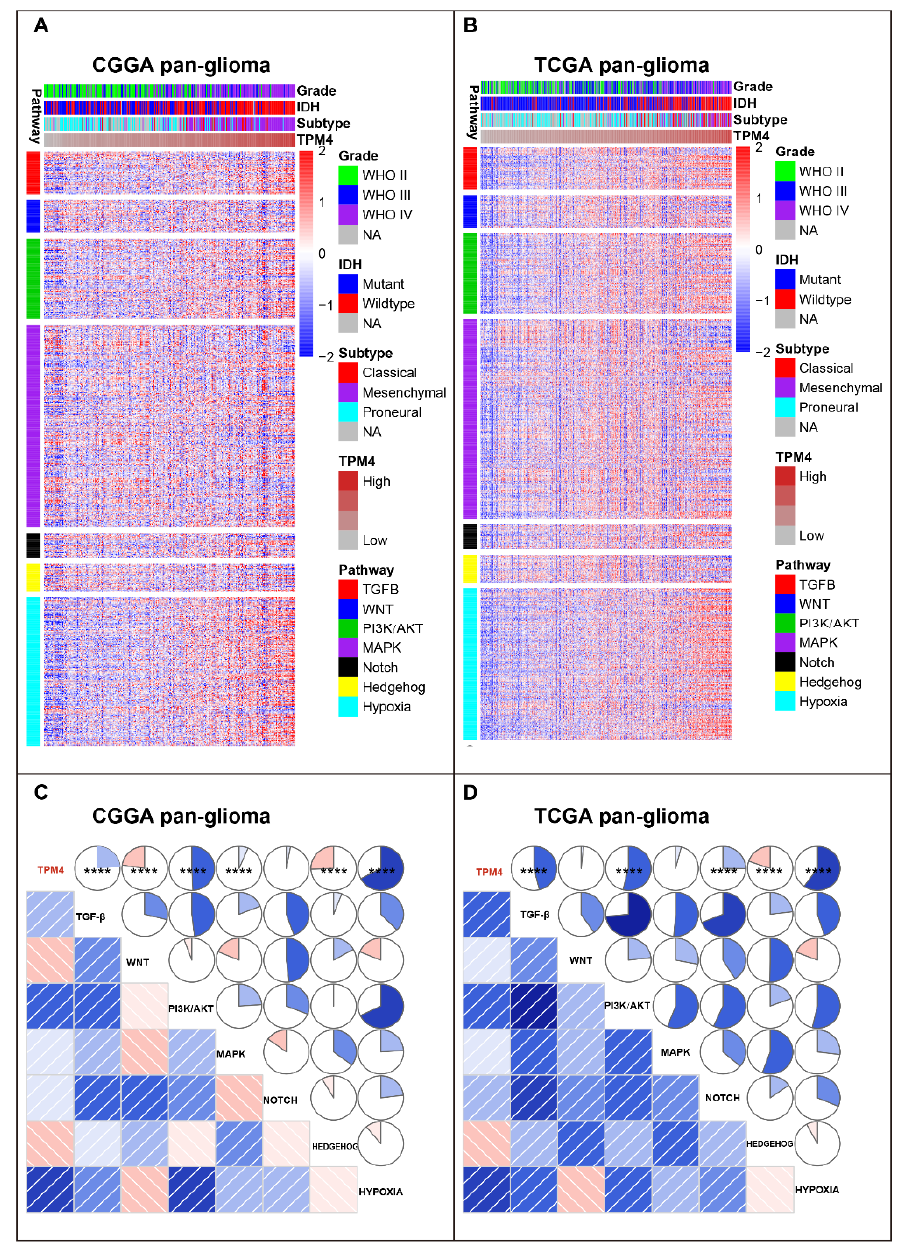
Figure 4. Cluster and gene set variation analysis (GSVA) of TPM4-related epithelial-to-mesenchymal transition (EMT) signaling pathways in pan-glioma. ( A ) Heatmap of representative genes of different EMT-related pathways in CGGA pan-glioma. ( B ) Heatmap of representative genes from different EMT-related pathways in TCGA pan-glioma. ( C ) Intercorrelation between TPM4 and seven metagenes in CGGA pan-glioma. ( D ) Intercorrelation between TPM4 and seven metagenes in TCGA pan-glioma. In ( C , D ), the blue and red colors represent positive and negative correlation, respectively. A darker color and a bigger sectorial area represent a higher correlation coefficient. **** indicates p value < 0.0001. In CGGA, Pearson correlation between TPM4 and TGF- β (R = 0.240, p = 2.542 × 10 − 5 ), WNT (R = − 0.225, p = 7.919 × 10 − 5 ), PI3K/AKT (R = 0.493, p < 2.2 × 10 − 16 ), MAPK (R = 0.065, p = 0.264), NOTCH (R = 0.029, p = 0.616), HEDGEHOG (R = − 0.256, p = 6.805 × 10 − 6 ), HYPOXIA (R = 0.672, p < 2.2 × 10 − 16 ). In TCGA, Pearson correlation between TPM4 and TGF- β (R = 0.461, p < 2.2 × 10 − 16 ), WNT (R = 0.017, p = 0.661), PI3K/AKT (R = 0.538, p < 2.2 × 10 − 16 ), MAPK (R = 0.040, p = 0.309), NOTCH (R = 0.252, p = 7.126 × 10 − 11 ), HEDGEHOG (R = − 0.197, p = 4.083 × 10 − 7 ), HYPOXIA (R = 0.599, p < 2.2 × 10 − 16 ); NA: not